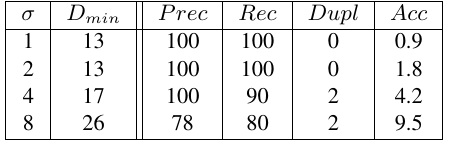
Table 2: Results on synthetic dataset for increasing σ (in cm ), N cam = 5 and E = 4 σ ref